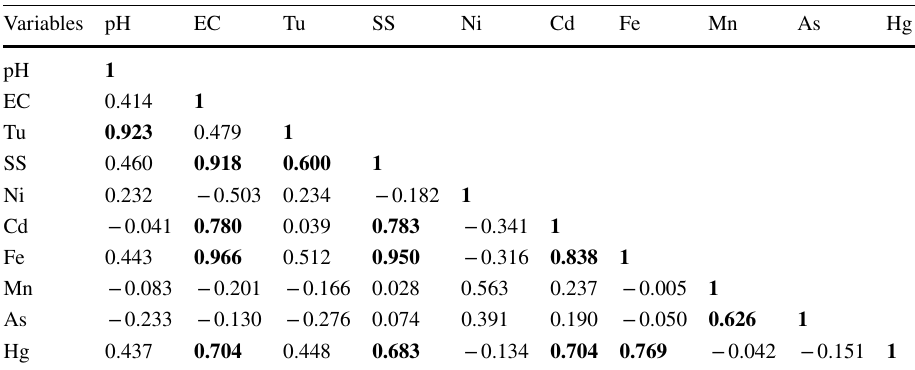
between physical parameters and heavy metals analyzed in water samples